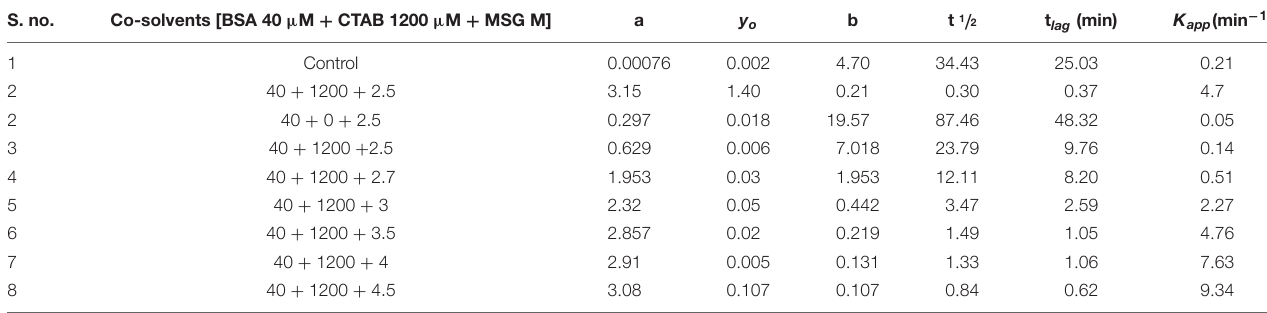
TABLE 4 | Change in kinetic parameters associated with CTAB-induced BSA aggregation in the presence of monosodium glutamate at varying concentrations from 0.1 to 4.5 M at temperature 70 ◦ C. S. no.